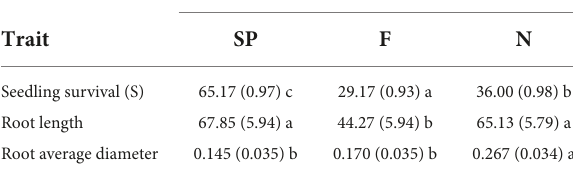
TABLE 3 Means and standard errors (in parentheses) of seedling tested traits; associated with the experimental variants (N, F,